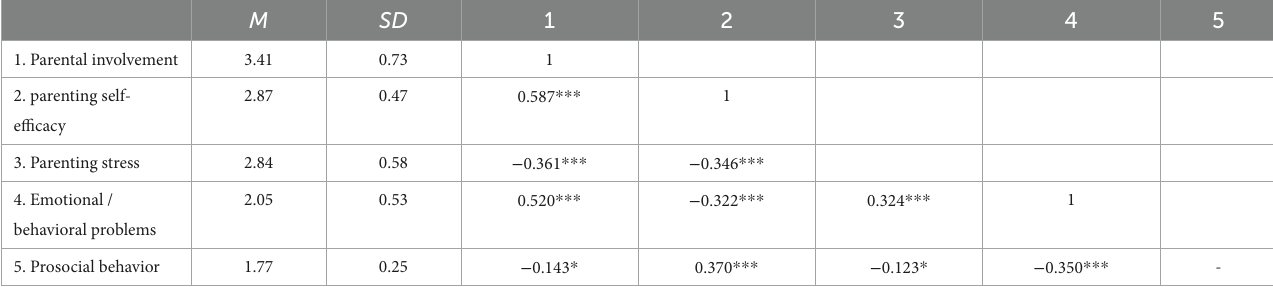
TABLE 2 Mean scores for parental involvement, parenting self-efficacy, parenting stress, emotional/behavioral problem, and prosocial behavior and summary of Pearson correlations between these variables. M